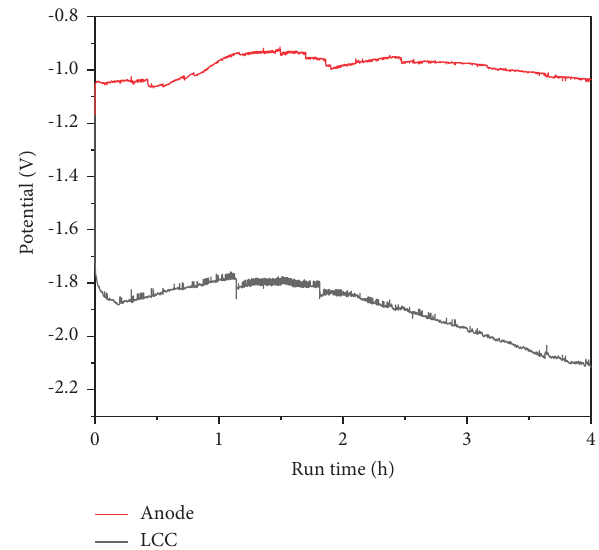
Figure 5: Potential profiles obtained during run 3 using the stirred LCC immersed in LiCl-KCl-UCl